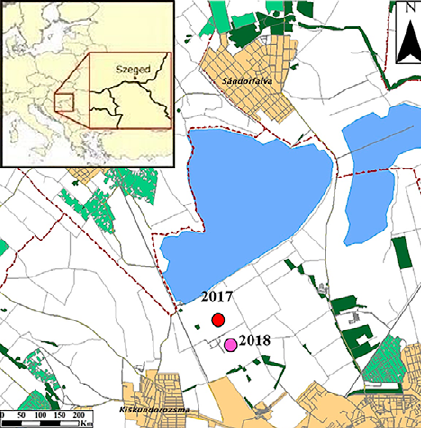
Figure 3. Sample